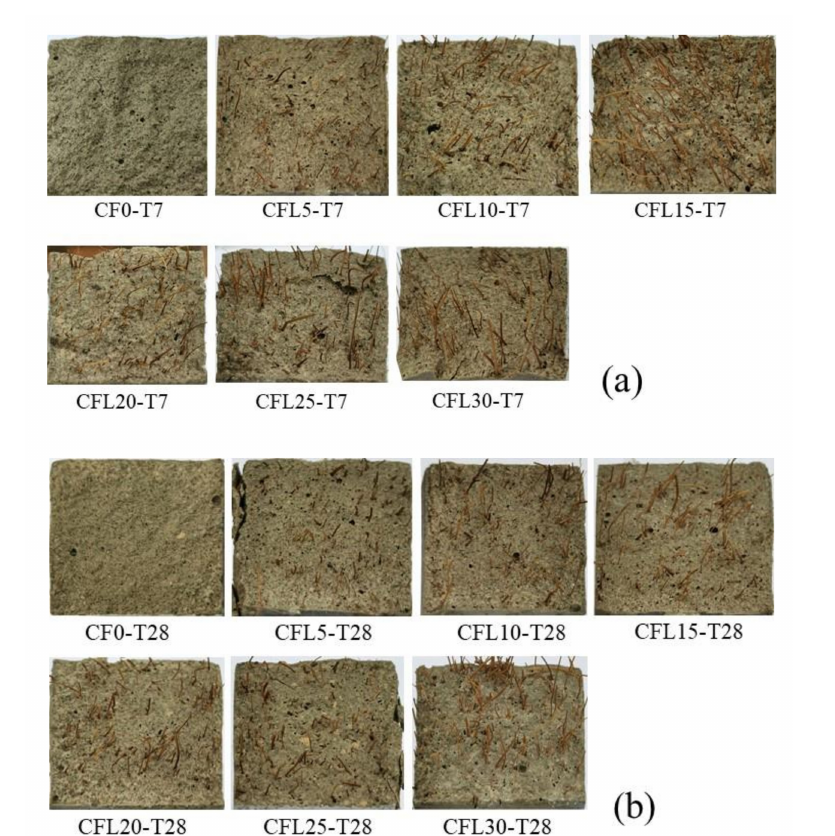
Figure 6. Section of failed specimens: ( a ) T7; ( b )